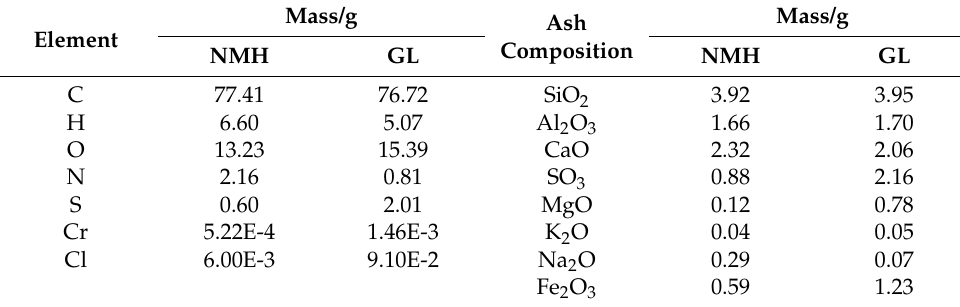
Table 5. Initial input value for calculation.